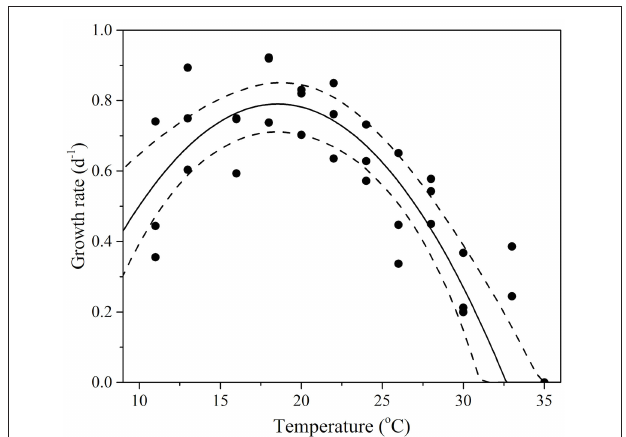
FIGURE 2 | Thermal performance curves of fitness in the cosmopolitan model diatom Thalassiosira pseudonana depicting growth rate as a function of temperature ( n = 33, RSME = 0.1). Each symbol represents a distinct biological replicate. The solid line corresponds to maximum likelihood estimate with broken lines corresponding to the 95% confidence intervals of the bell-shape function (Equation 1) estimated by parametric